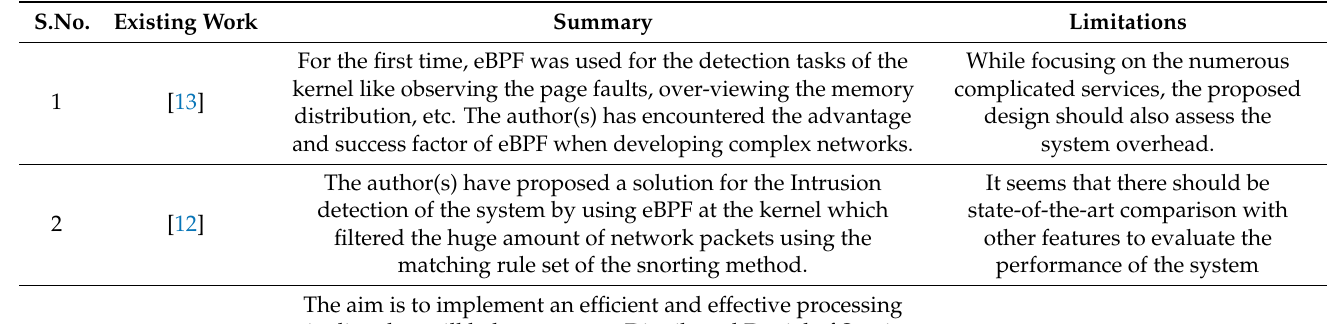
Table 1. Summary of related